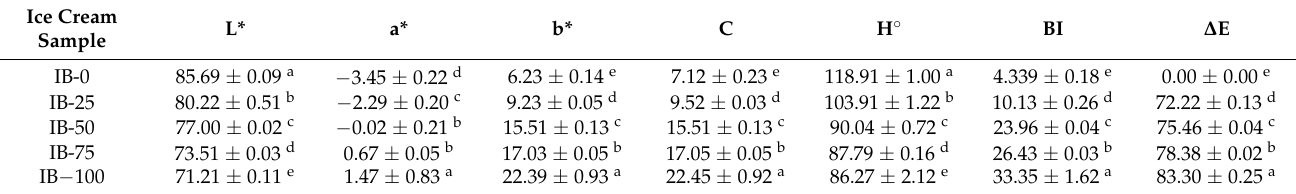
Table 7. Color changes of ice cream samples of ice cream incorporating ADFP.